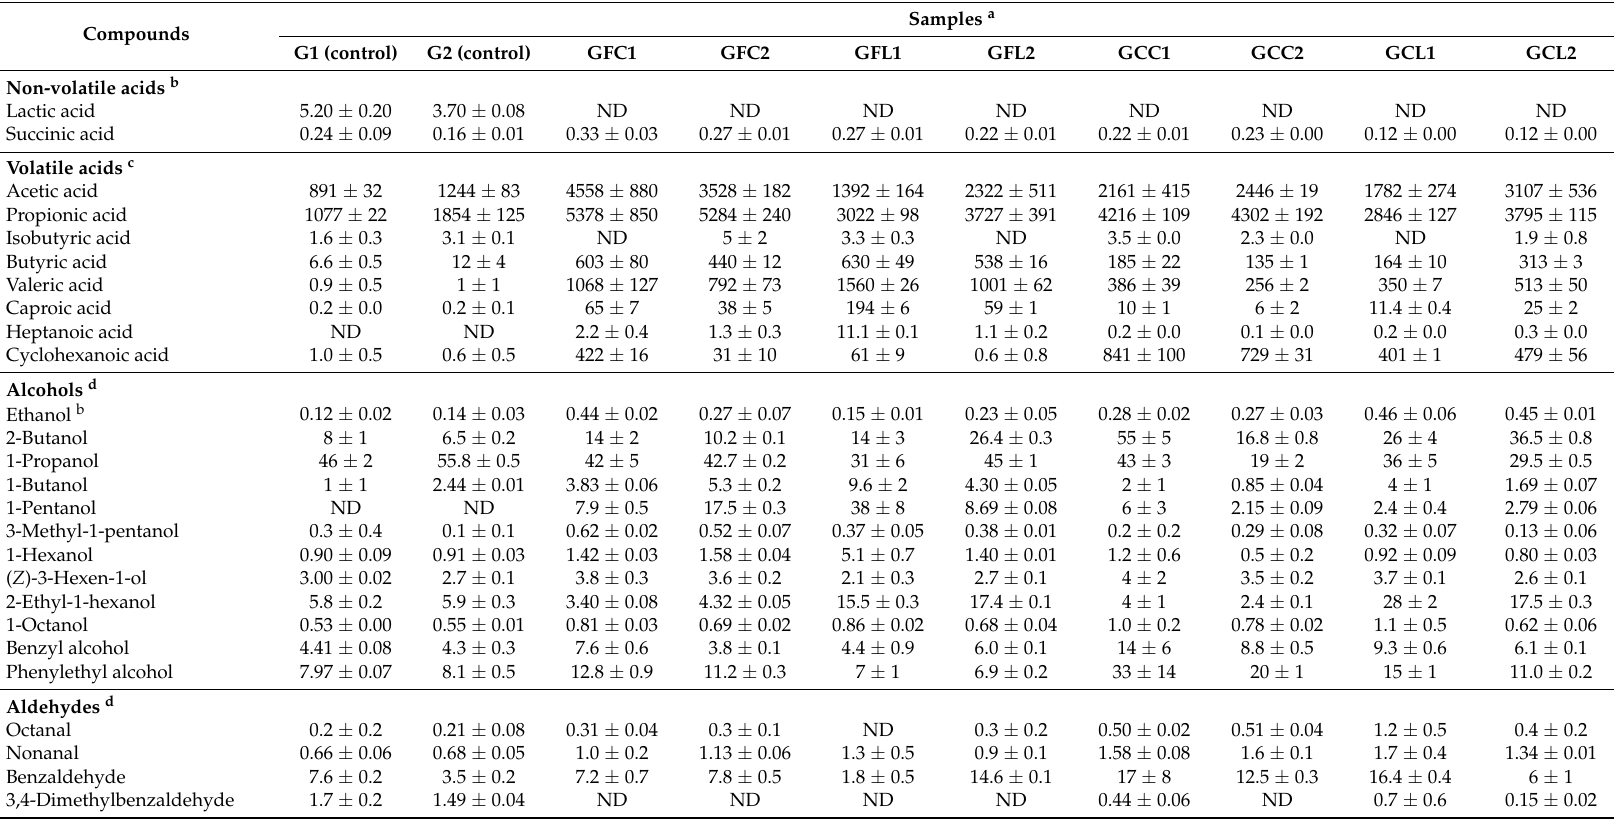
Table 2. The concentration of metabolites in spoiled and unspoiled (control) brine samples from the Gordal